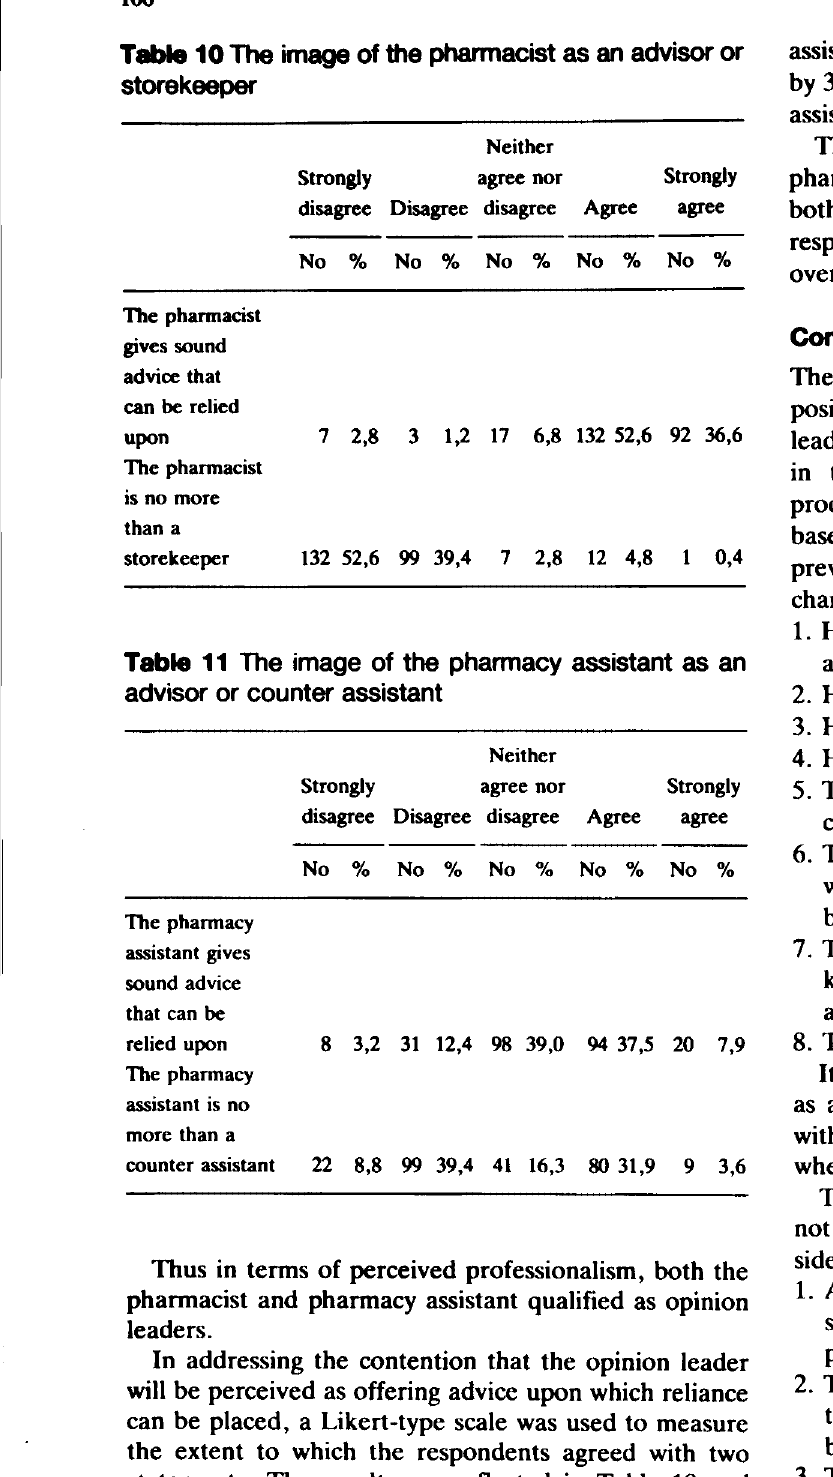
Table 10 The image of the pharmacist as an advisor or storekeeper